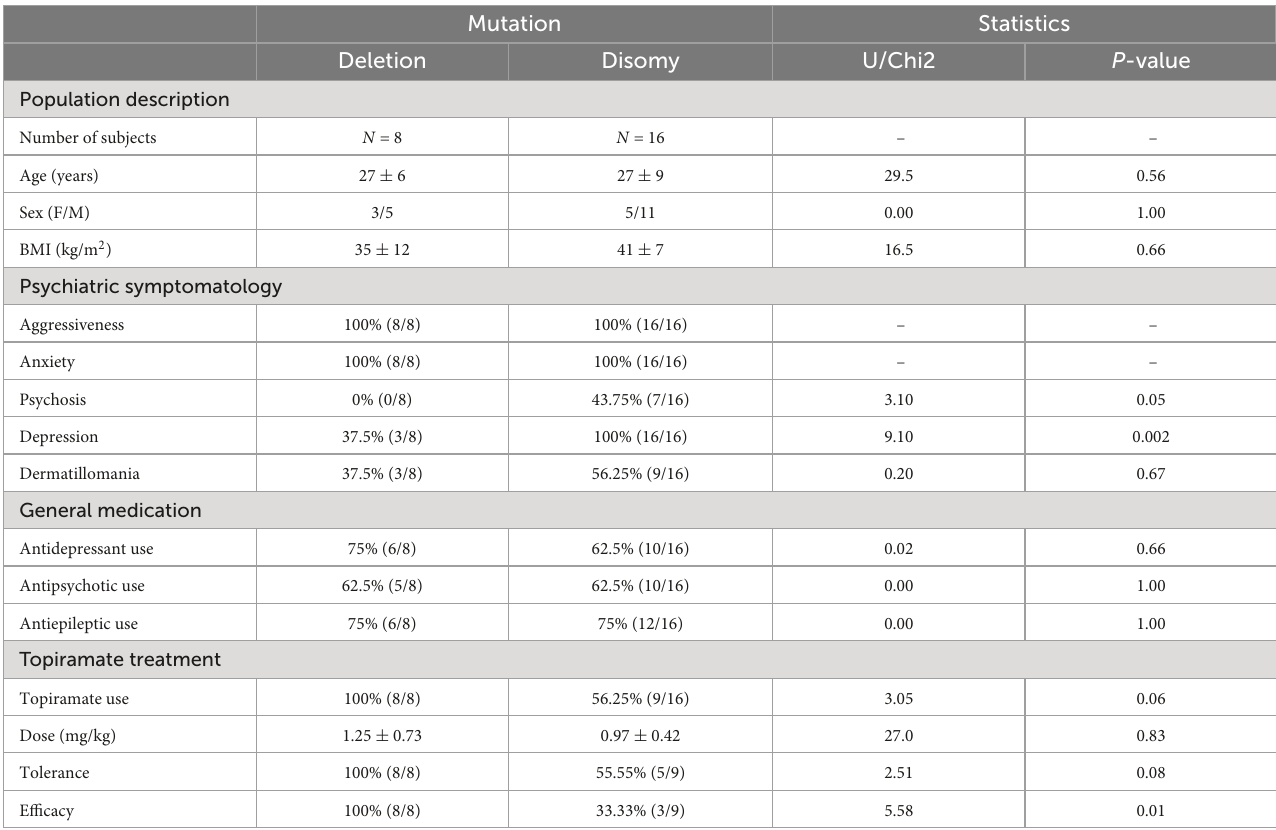
TABLE 1 Clinical and treatment response